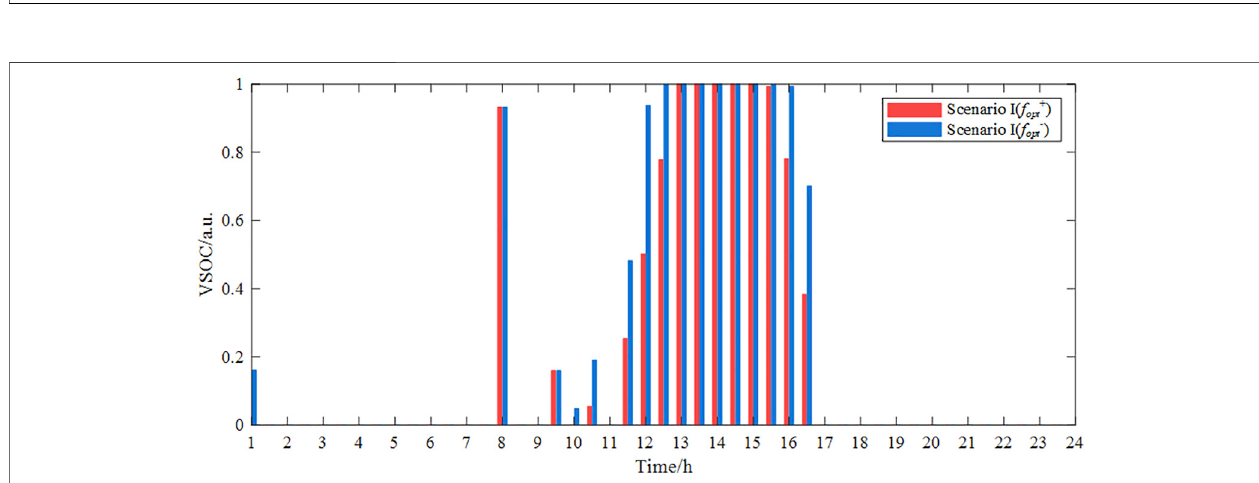
FIGURE 15 | VSOC when the optimal scheduling results are f opt- and f opt+ for Scenario I.